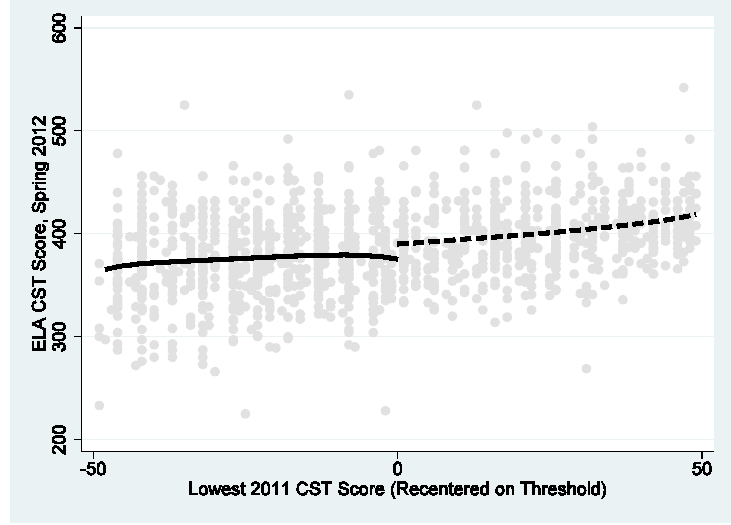
Figure S4: Regression discontinuity analysis of the effect of white card placement on Spring 2012 ELA CST scores, for 2011-12 Live Oak and Mann students (200% of preferred bandwidth: 26.6)